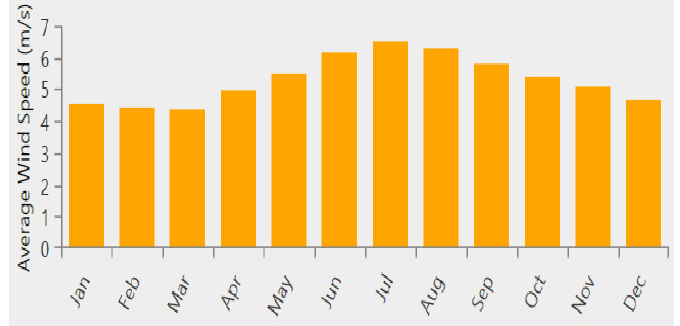
Figure 9. Monthly average wind speed for Windhoek.